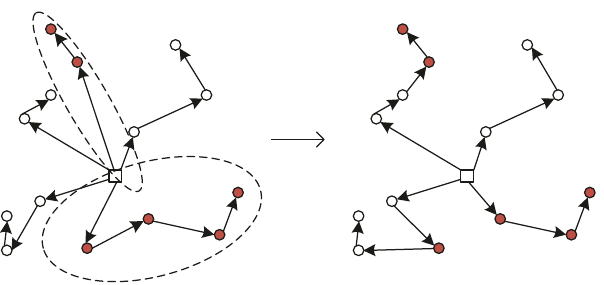
Figure 5: Random-route-improvement